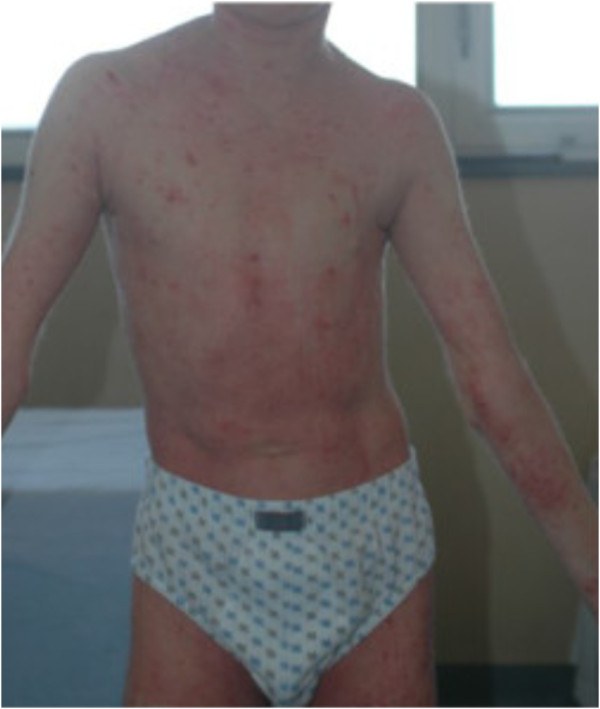
Atopic dermatitis.